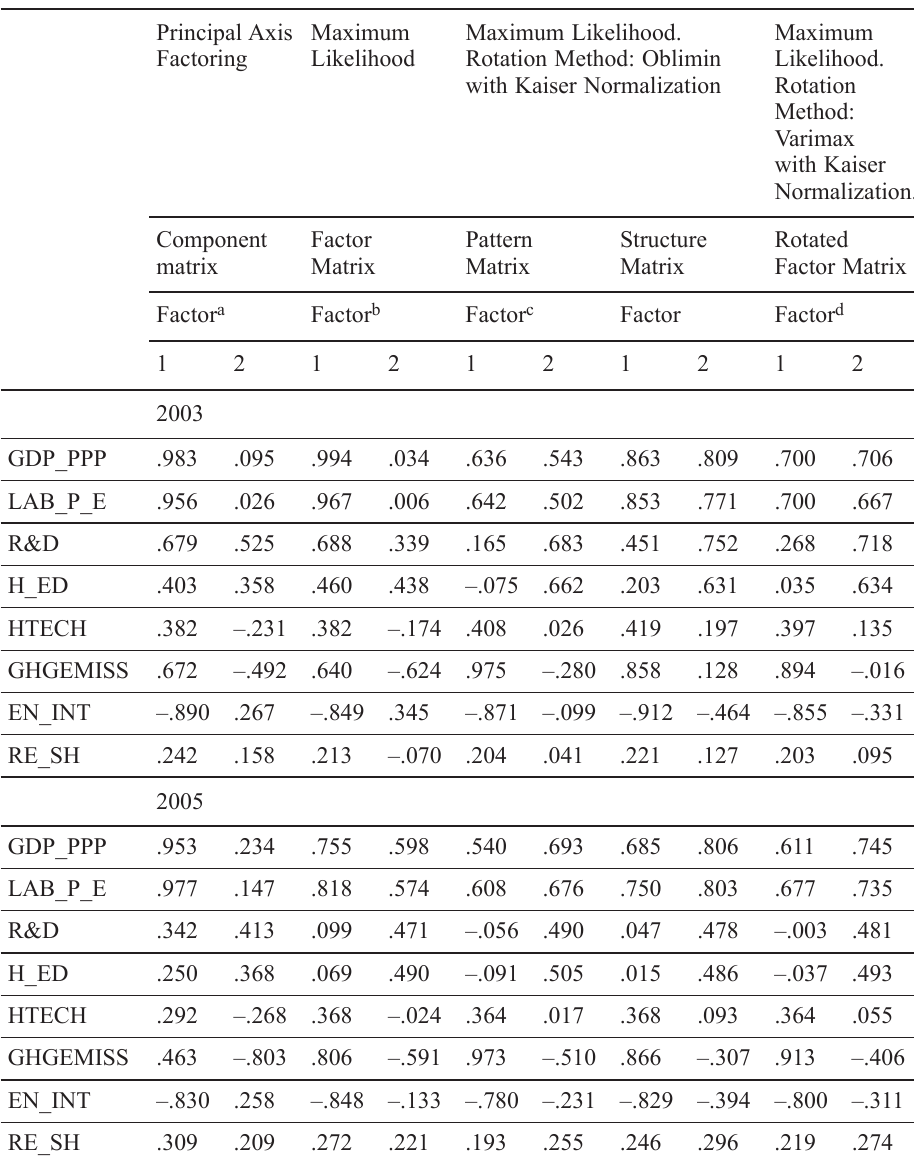
Table 9. Multivariate factor analysis and matrices of fi ve different extraction methods (two components extracted) in 2003 and 2005 Principal Axis Maximum Maximum Likelihood. Maximum Factoring Likelihood Rotation Method: Oblimin Likelihood. with Kaiser Normalization Rotation Method: Varimax with Kaiser Normalization. Component Factor Pattern Structure Rotated matrix Matrix Matrix Matrix Factor Matrix Factor c Factor Factor